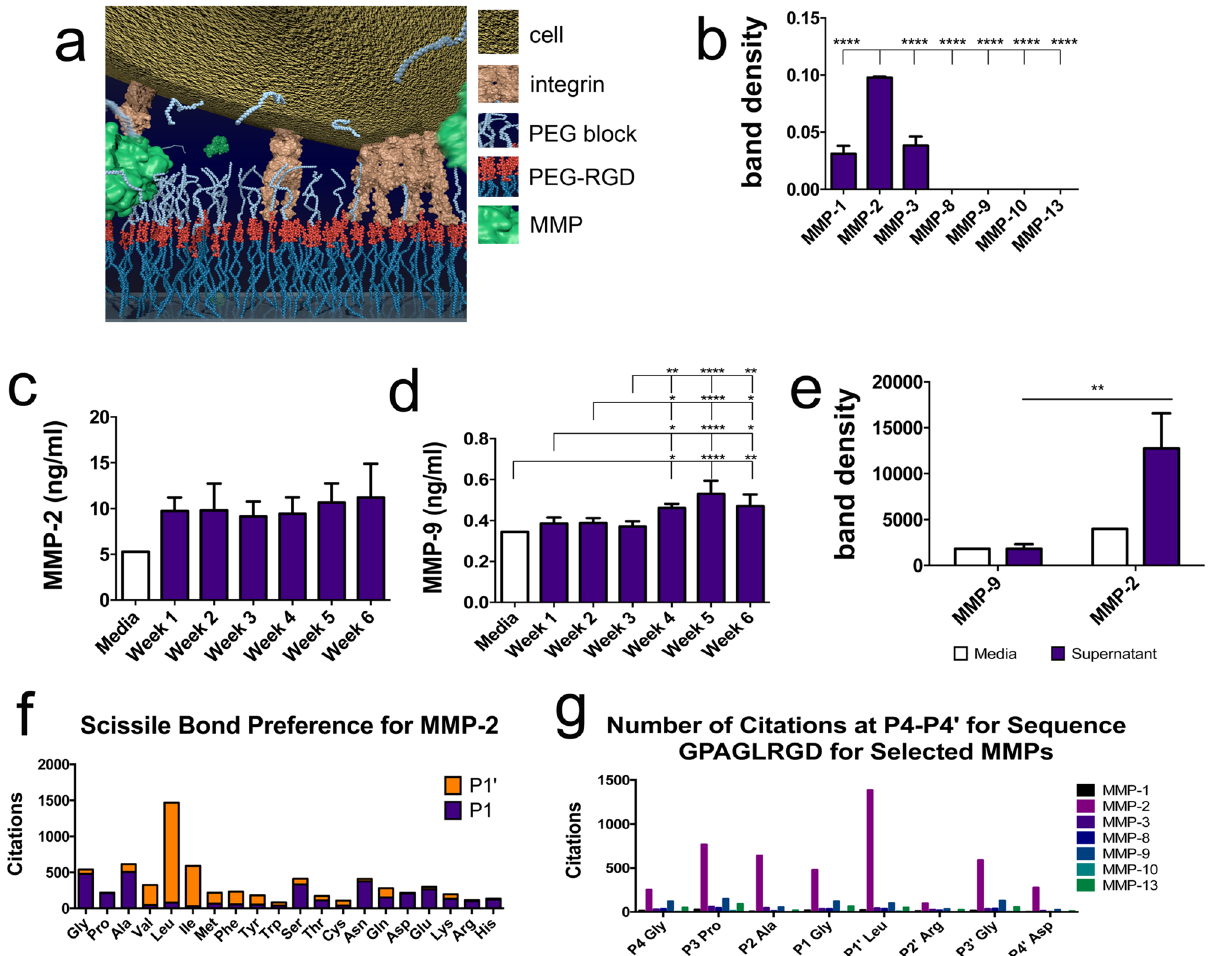
Figure 1. Selecting MMPs and cleavage sequence. ( a ) Schematic of the SSC cleavable surface concept with MMP-driven removal of PEG revealing RGD to the cells. ( b ) After 3 weeks of culture, MMP protein array was performed by densitometry measurements of the array membranes demonstrating high levels of MMP-2 expression (n = 3). ( c,d ) ELISA showed constant expression of MMP-2 and increasing expression of MMP-9 with time (n = 3). ( e ) Zymography was used to show that only MMP-2 was expressed by the SSCs in active form after 3 weeks of culture (n = 3). ( f ) MERPOS data gave consensus of an 8-amino acid sequence with a strong preference for L at P1 ′ ; allowing us to design a GPAG ↓ LRGD sequence for MMP-2 cleavage that would leave RGD on the coverslip. ( g ) GPAG ↓ LRGD sequence is highly cited as being MMP responsive For ( b–e ), results are mean ± SD, statistics by ANOVA and Tukey test where *p < 0.05, **p < 0.01, ***p < 0.001 and ****p < 0.0001. If stars are not shown on the graphs in ( b–e ), it denotes no significant difference was observed between the treatment and relevant